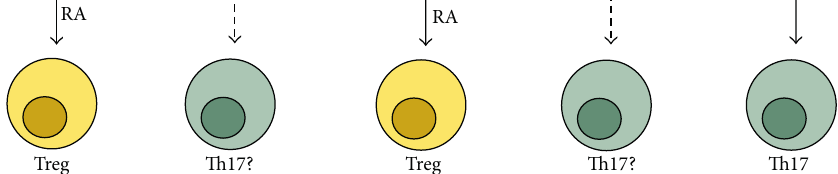
Figure 1: Ontogenetic development of intestinal dendritic cells subpopulations. Adapted from Guilliams et al. [35] and expanded by findings from Scott et al. [13]. See text for details. Common dendritic cell progenitor (CDP), preplasmacytoid dendritic cell (pre-pDC), precommon dendritic cell (pre-cDC), plasmacytoid dendritic cell (pDC), common dendritic cell (cDC), aldehyde dehydrogenase (ALDH), regulatory T cell (Treg), retinoic acid (RA), and T-helper 17 cell (Th17). Arrows with solid lines represent published data, and arrows with broken lines represent speculative hypotheses with missing final